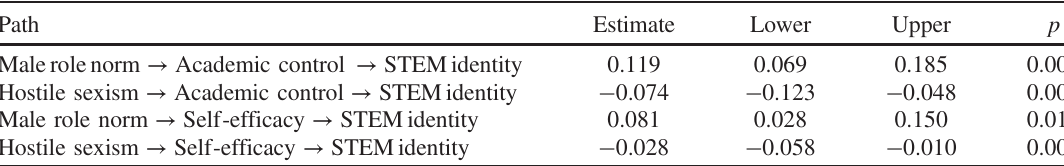
TABLE IV. Unstandardized indirect effects of the gender stereotypes on disciplinary identity (whole sample).